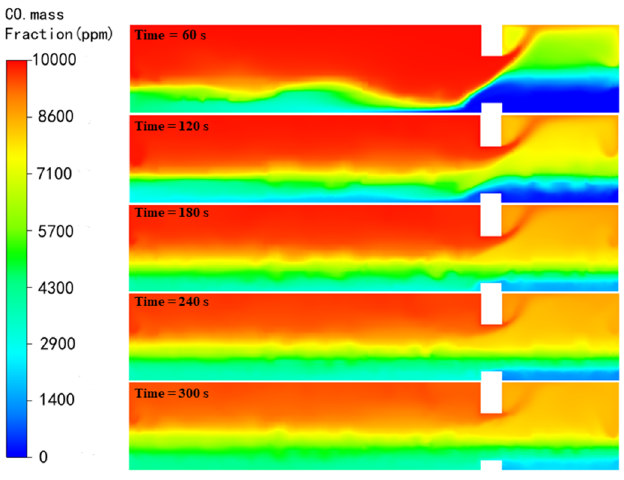
Figure 10. Cloud diagram of CO concentration in the transition room without air curtain at Y = 1.805